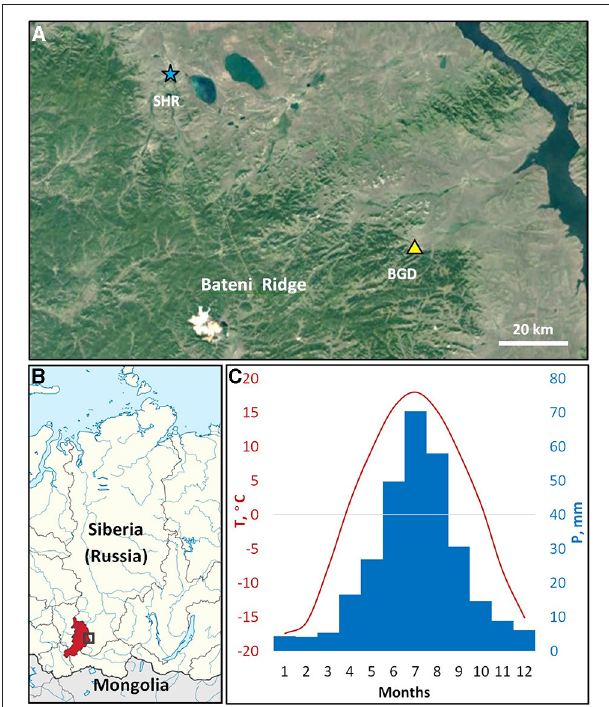
FIGURE 1 | The study area. The territorial location of the sampling site (BGD; triangle) and the Shira meteorological station (SHR; asterisk) in the northern part of the Bateni Ridge, Kuznetsky Alatau mountain system (A) . The location of the study area (rectangle) in Siberia, Russia (B) ; color marks administrative region, the Republic of Khakassia. Climatic diagram of average monthly temperatures (1966-2008; line) and precipitation (1936-2008, bars) at the Shira station (C) . Background maps: satellite data © 2020 Google; schematic map is fragment of Map of Khakassia within Russia (CC BY-SA